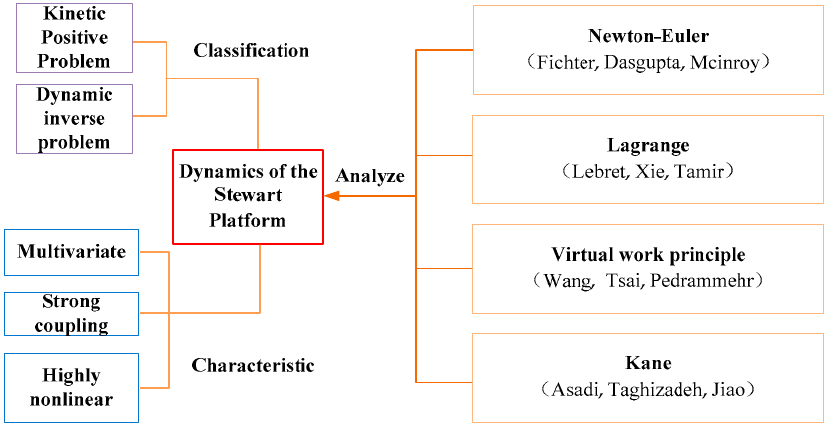
Figure 11. Studies on dynamics of the Stewart Platform [26,50,75–90].